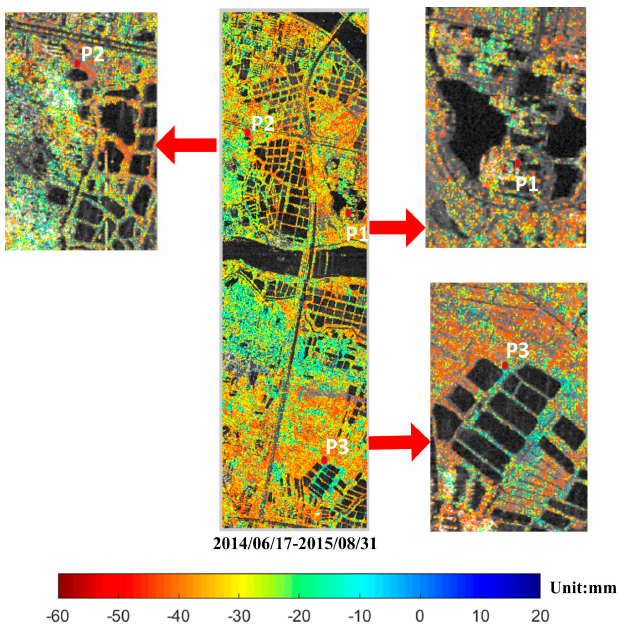
Figure 20. ( a ) Three points (p1–p3) on deformation map of time period 2014/06/17–2015/08/31 and the corresponding enlarged maps; ( b ) Temperature of Fuoshan over period 2015/01–2015/12.